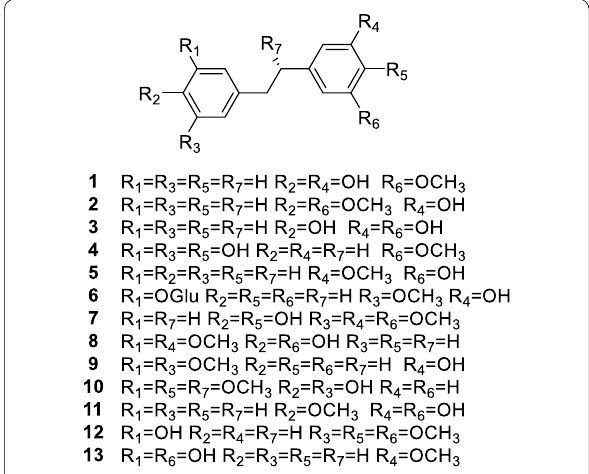
Fig. 6 The structure of 13 bibenzyl derivatives in this